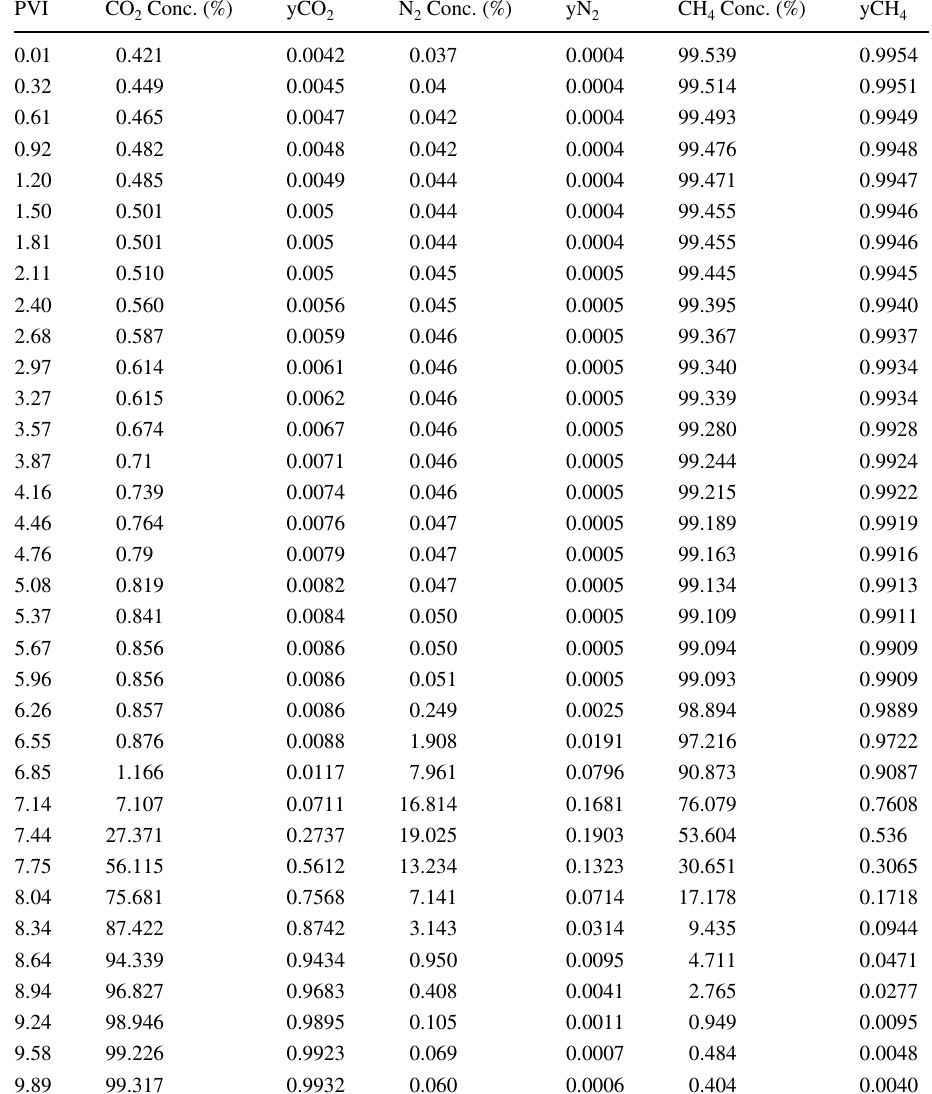
Table 6 Effluent concentrations at 1 PV of cushion gas